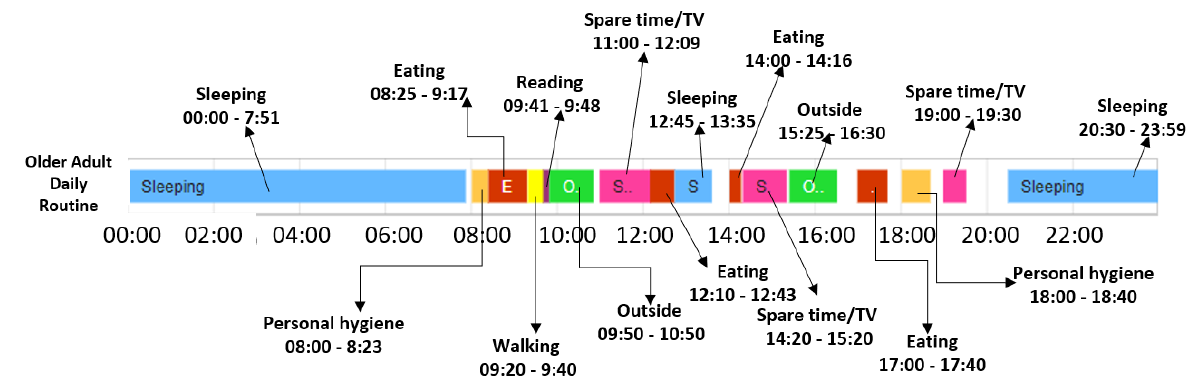
Figure 8. Daily routine extracted for older adult M1. Based on the identified baseline and on the days from the five folds considered for baseline detection that are like the baseline in terms of sequence of activities, a confidence interval and a confidence duration were determined for each older adult considered. For example, in the case of the older adult M1, a confidence interval of [0.0794, 0.0829] was determined using Formula (7) while the confidence duration was determined as